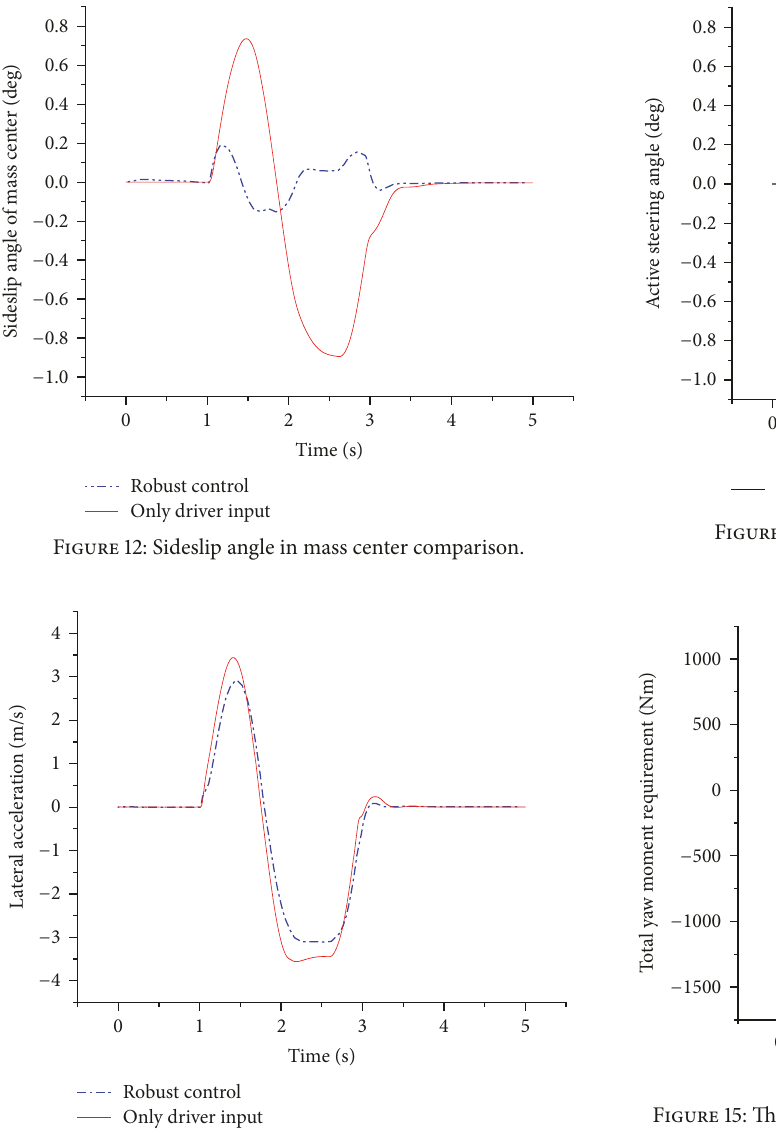
Figure 13: Lateral acceleration in mass center comparison.